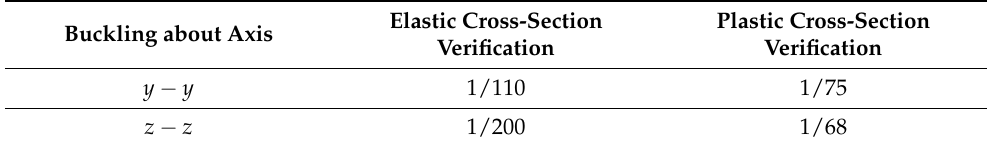
(cid:2868),(cid:2915)(cid:2922),(cid:2935) .